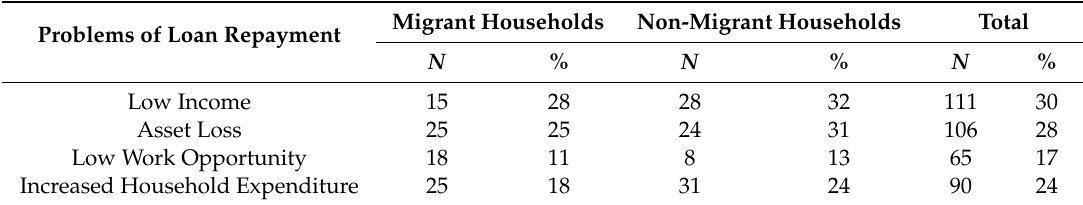
Table 11. Problems of loan